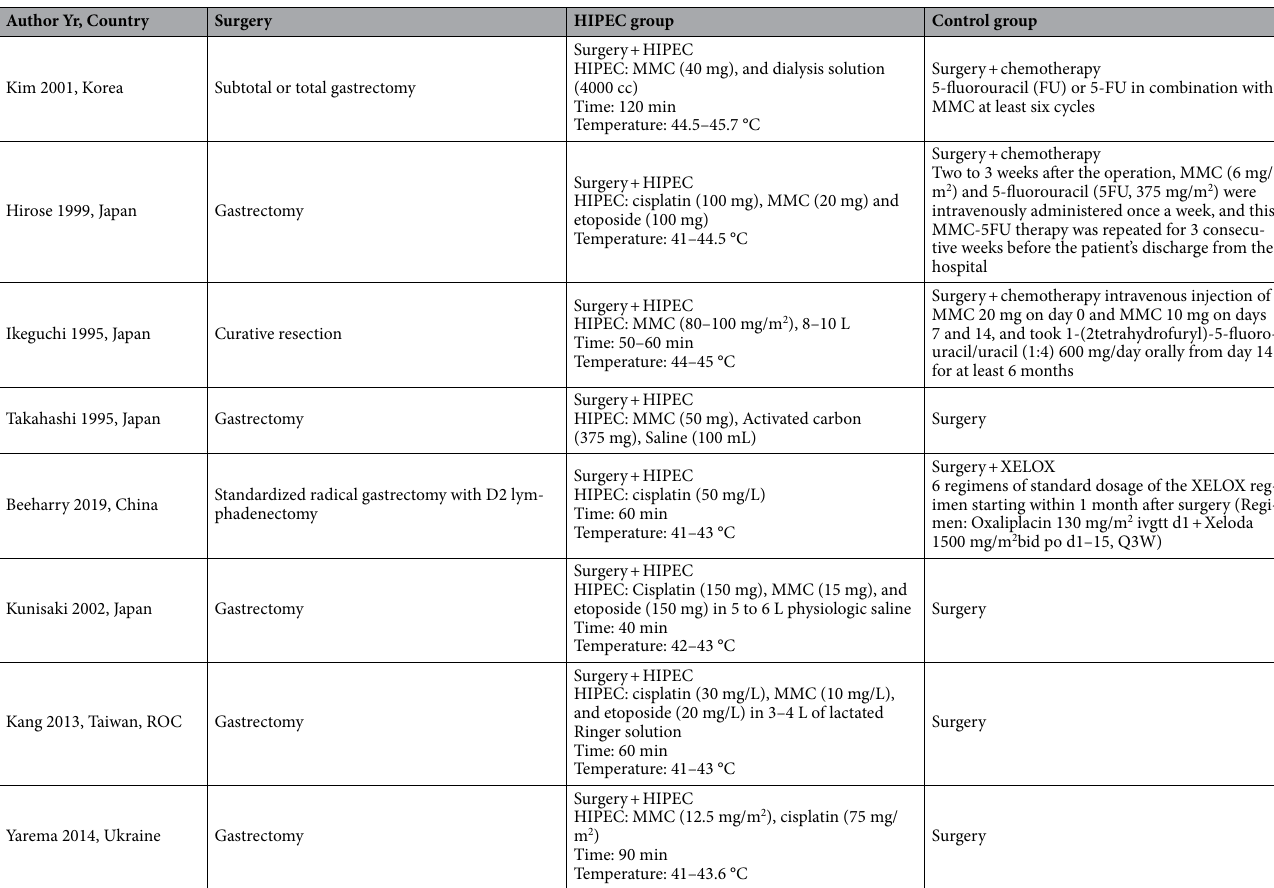
Table 4. Summary of the treatments in the 22 eligible studies. HIPEC hyperthermic intraperitoneal chemotherapy, Yr year, MMC mitomycin